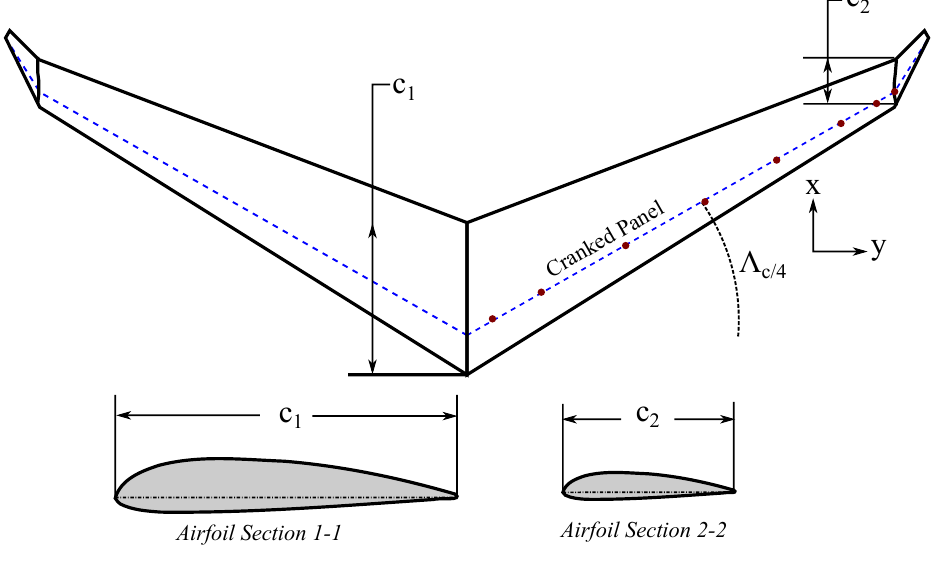
Figure 10. Cranked wing parameter